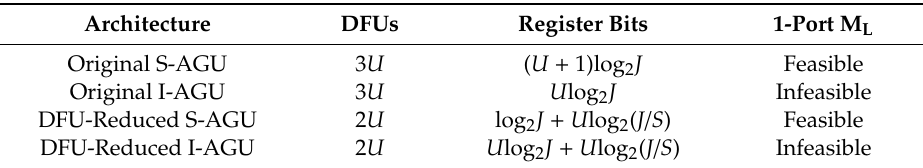
Table 2. Comparison of AGU architectures.